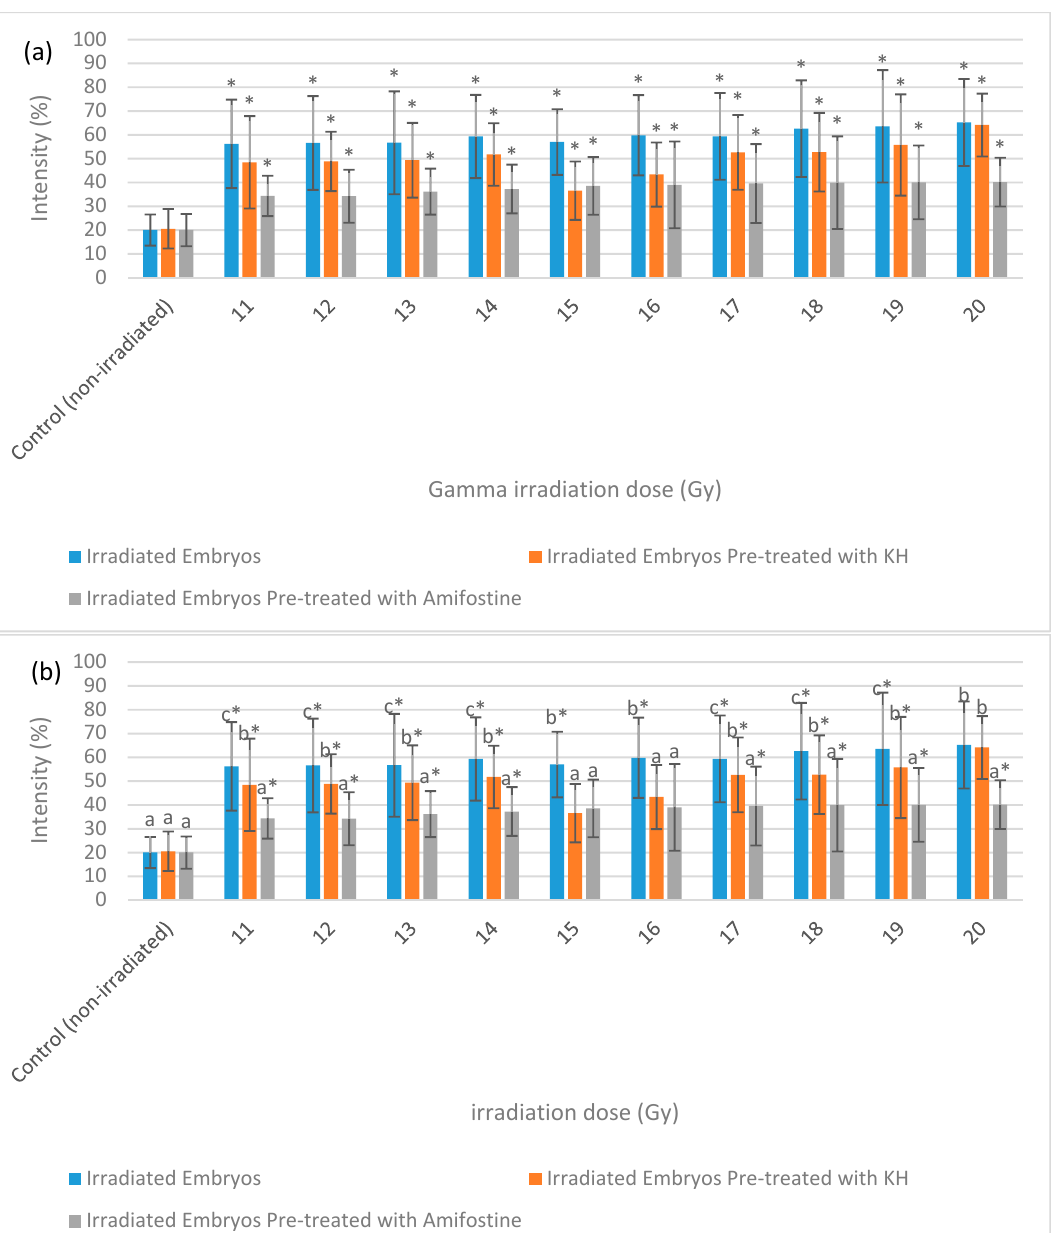
Figure 8. Intensity (%) of γ‐ H2AX in irradiated and non ‐ irradiated zebrafish embryos. ( a ) γ‐ H2AX intensity in irradiated and non ‐ irradiated embryos. (*) indicates significant difference ( p < 0.05) as compared to control; ( b ) γ‐ H2AX intensity in untreated and embryos pre ‐ treated with KH and amifostine. a*, b* and c* indicate significant difference ( p < 0.05) compared to other treatment groups.